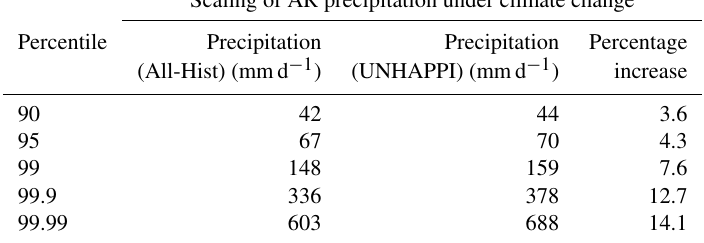
Table 5. Scaling relationships for extreme TC precipitation at var- ious percentiles in the Gulf of Mexico. The increase in mean SSTs in the Gulf of Mexico between All-Hist (299.5K) and UNHAPPI (301.3K) is 1.8K, which results in a CC scaling of 12.6%. We see that extreme precipitation here scales well above CC scaling,